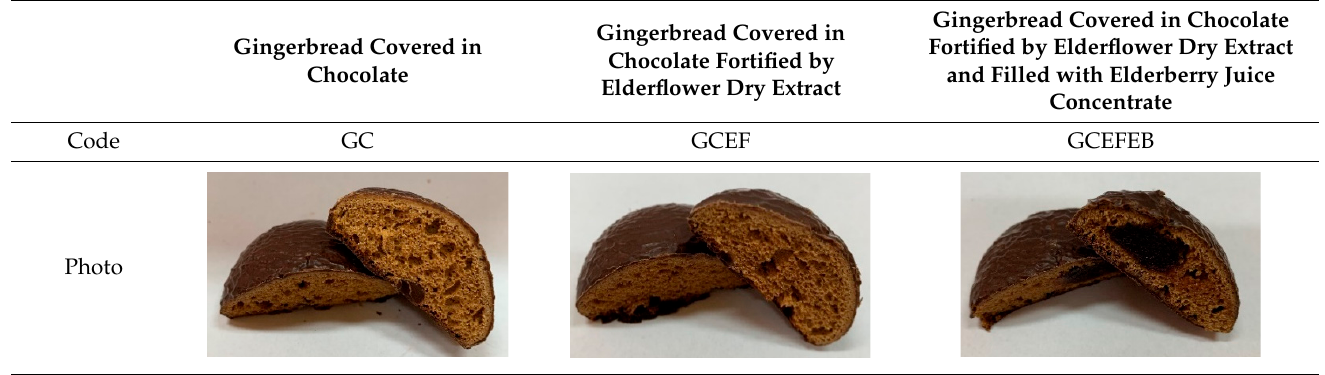
Table 6. Photos and ingredients of the three types of gingerbread cookies produced.